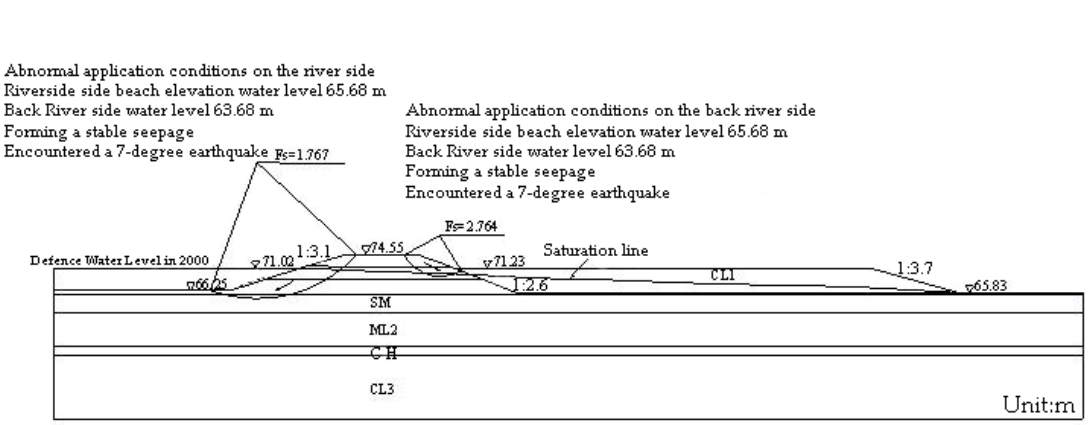
Figure 17. Calculation results of seismic stability of typical dike section.